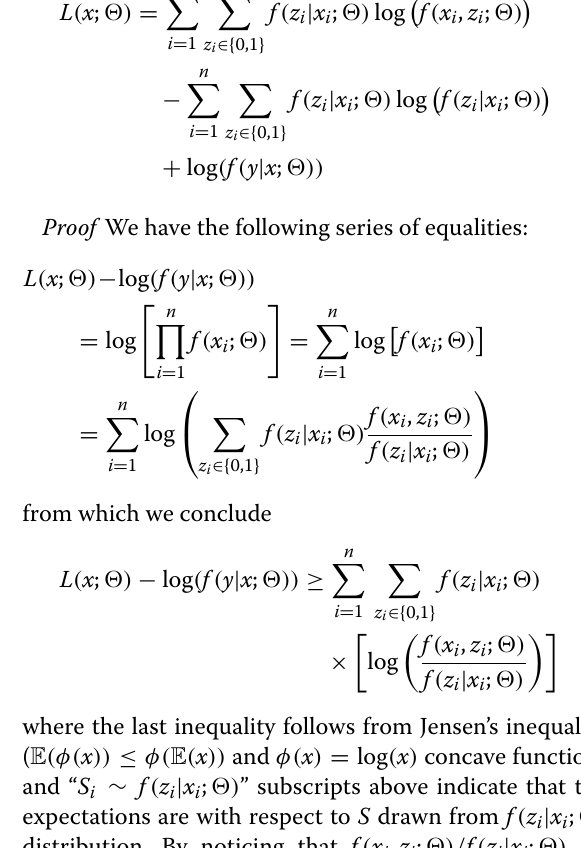
and (cid:31) ∞ x 2 p ( x ) d x = ( 1 − p )α 2 + p β 2 0